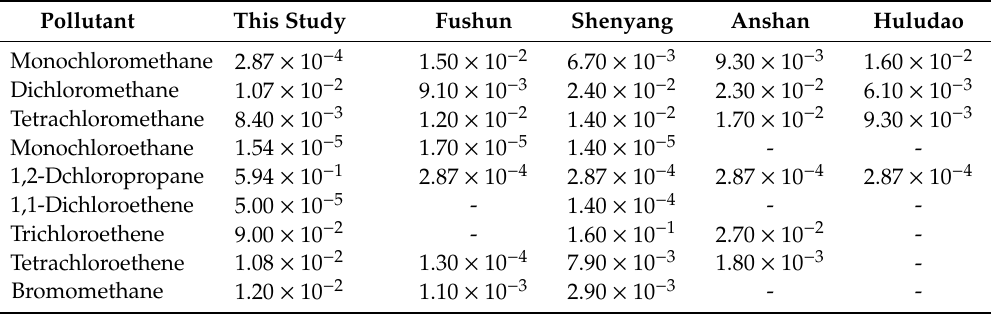
Table 5. Comparison of non-carcinogenic risk assessments for nine volatile halogenated hydrocarbons in Liaoning Province [12] and this